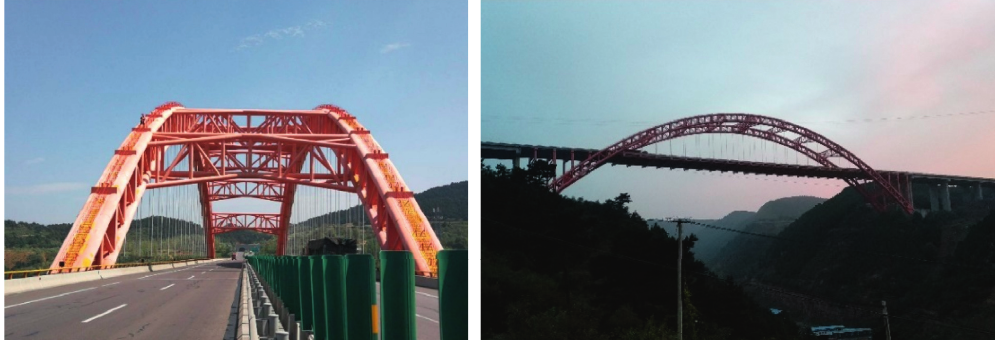
Figure 3: Beishengou concrete-filled steel tube arch